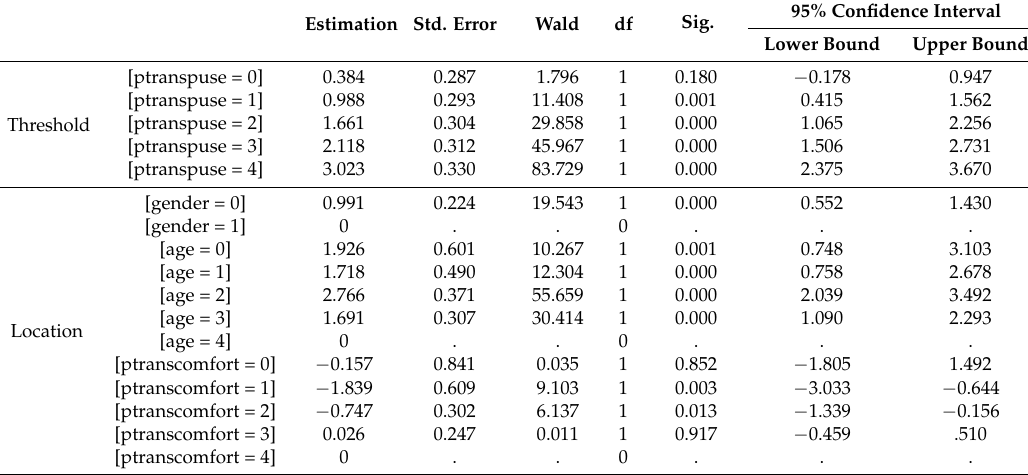
Table A4. Parameter Estimates for the public transport